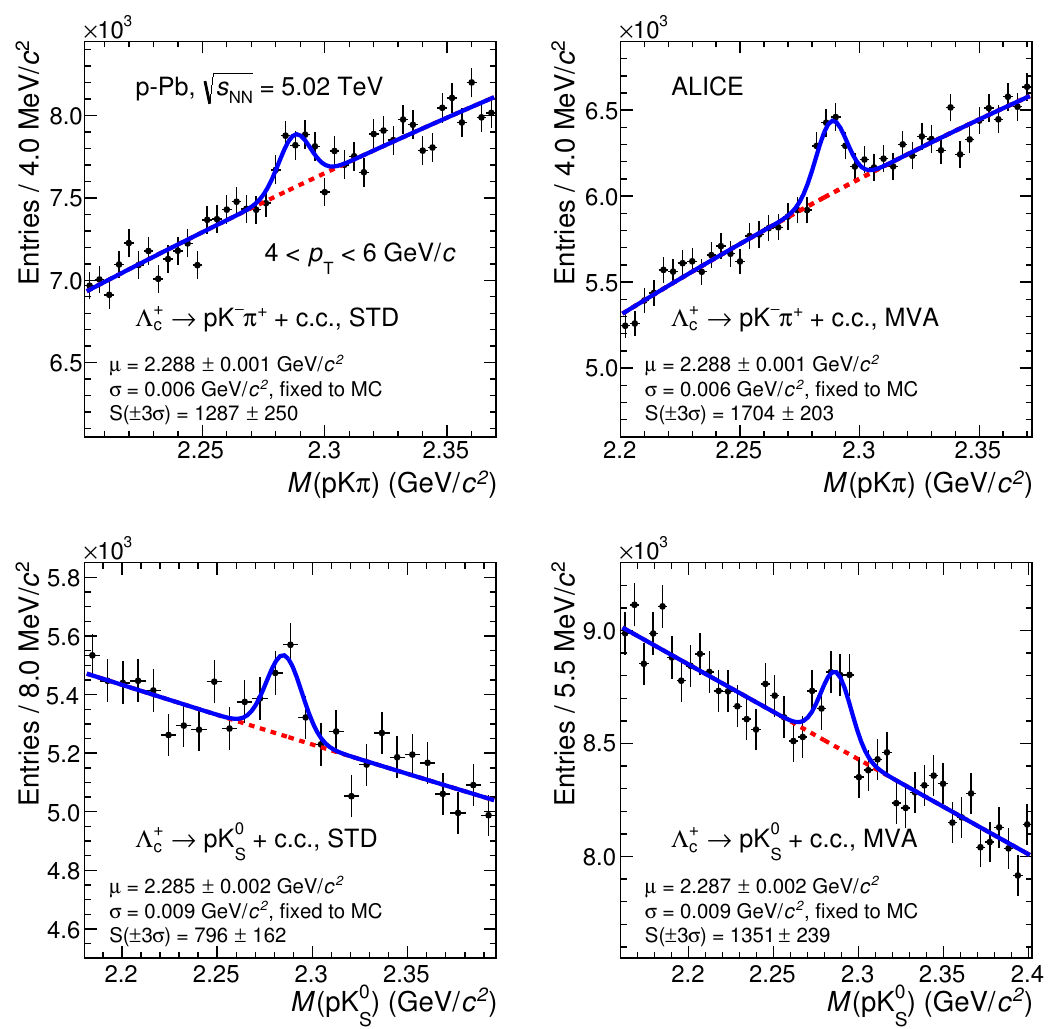
Figure 4 . Invariant-mass distribution of (cid:3) + GeV/ c in p-Pb collisions at while the solid lines represent the total (cid:12)t function. Top-left: (cid:3) + (cid:3) + ! pK (cid:0) (cid:25) + MVA, bottom-left: (cid:3) + c